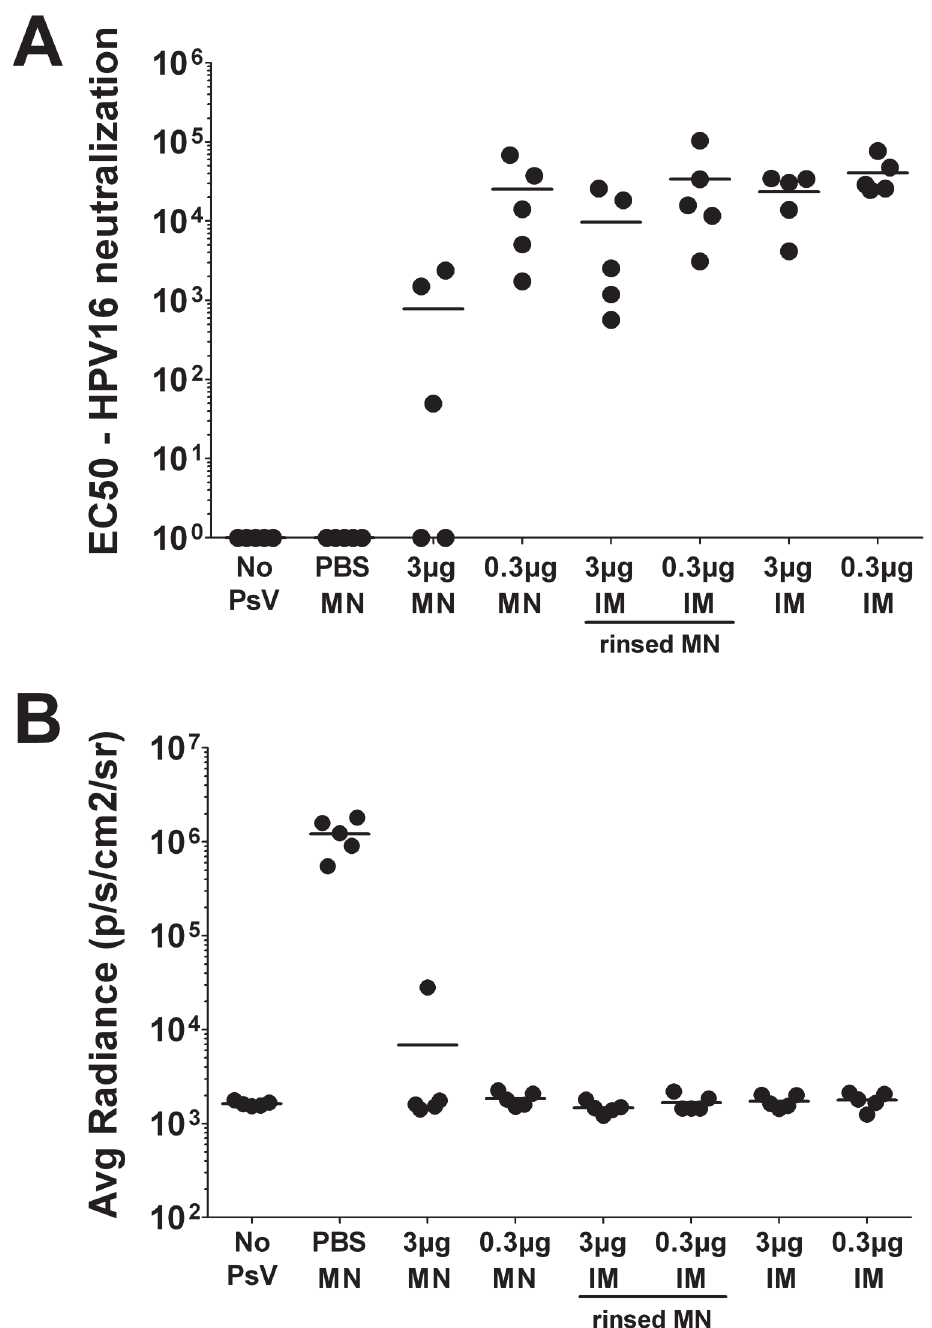
Fig 1. HPV16 L1 VLPs are immunogenic after coating onto microneedles. Animals were vaccinated with two different doses (3 μ g and 0.3 μ g) of HPV16 L1 VLPs by microneedle (MN), or intramuscular (IM) injection. An additional group composed of animals receiving an intramuscular injection of VLPs rinsed off of the microneedles was added in order to ensure immunogenicity was retained during the coating process. (A) Neutralizing antibodies against HPV-16 as measured in the sera of animals on the day of cervicovaginal challenge. Data reported as EC50, the reciprocal dilution at which 50% of the pseudovirus was neutralized compared to positive control wells. (B) In vivo bioluminescence after challenge with HPV16Luc (HPV PsV encapsidating the firefly luciferase gene). The “ No PsV ” group was not challenged in order to serve as a negative control group for luminescence. Data reported as average radiance; n =